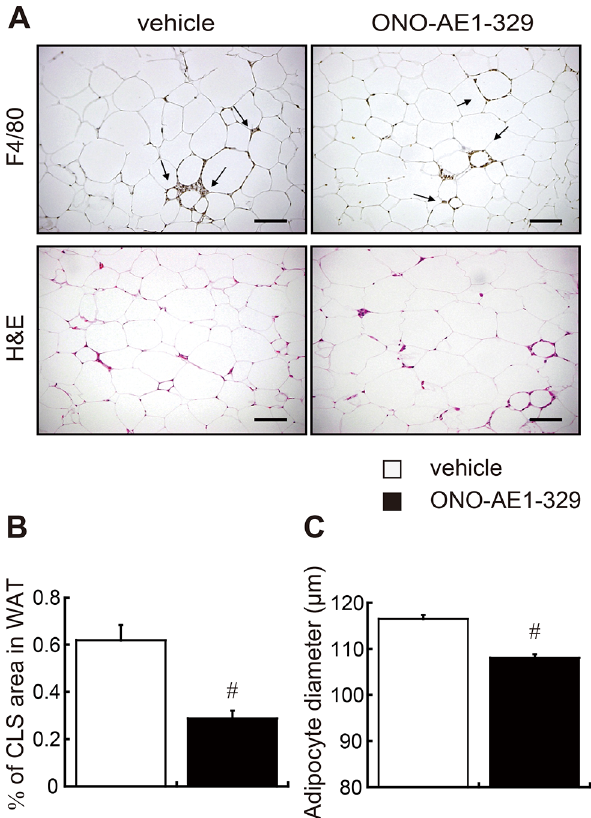
Fig 2. Adipose tissue morphology. (A) Representative images of epididymal adipose tissue stained with anti-F4/80 antibody (upper panel; the arrows indicate F4/80-positive cells) and H&E (lower panel) in db/db mice administered EP4 agonist (right column) or vehicle (left column). Scale bars: 100 μ m. (B) Percent of F4/ 80 + CLS areas in mouse epididymal adipose tissue (n = 7 each). (C) Quantification of adipocyte size (n = 7 each). All values are mean ± SEM. ] p < 0.01 vs. vehicle. CLS, crown-like